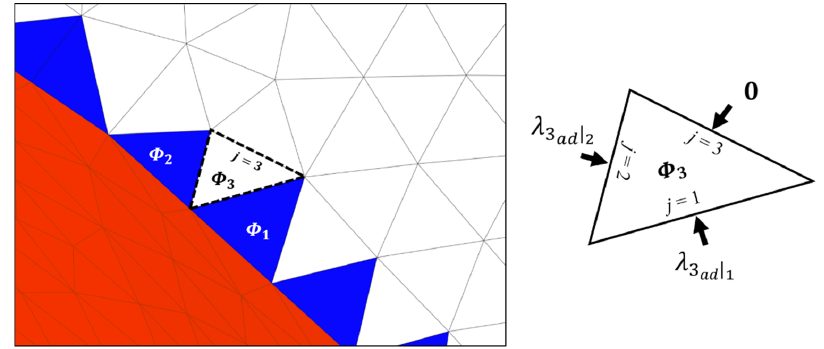
Figure 11. Second step of the propagation procedure of the proposed algorithm.